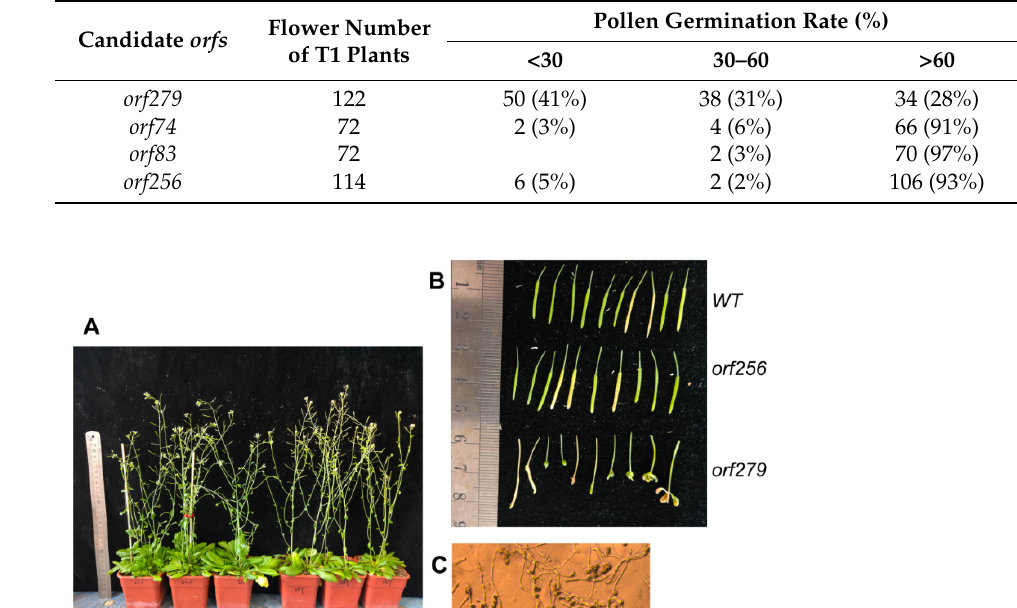
Table 8. Pollen germination rate of transgenic plants.